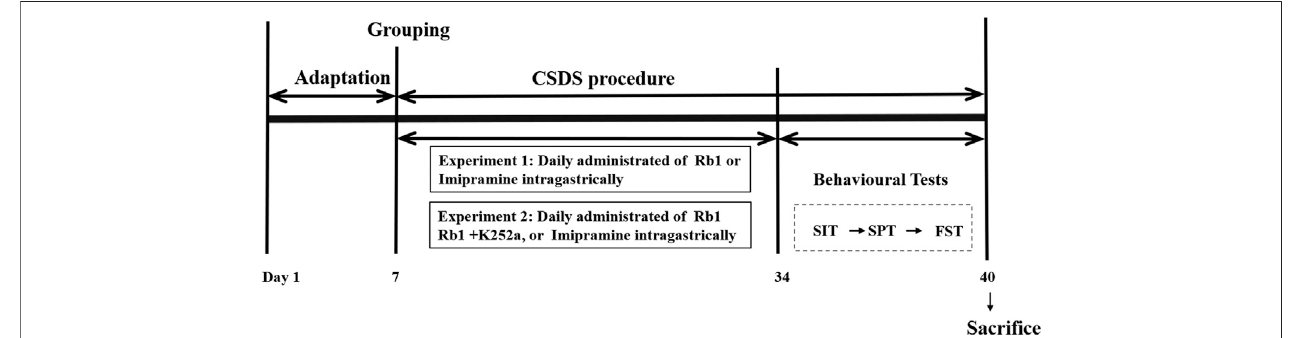
FIGURE 1 | Experimental design. Ginsenoside Rb1, Rb1; chronic social defeat stress, CSDS; social interaction test, SIT; sucrose preference test, SPT; forced swim test,